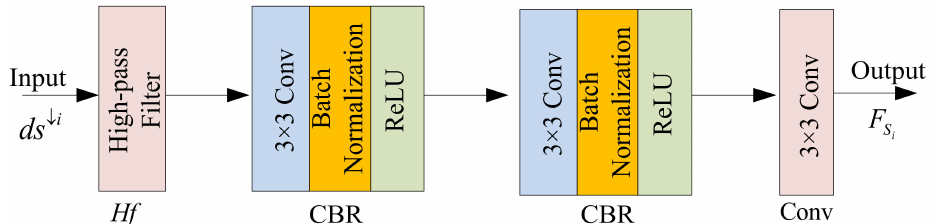
Figure 2. Spatial feature extraction